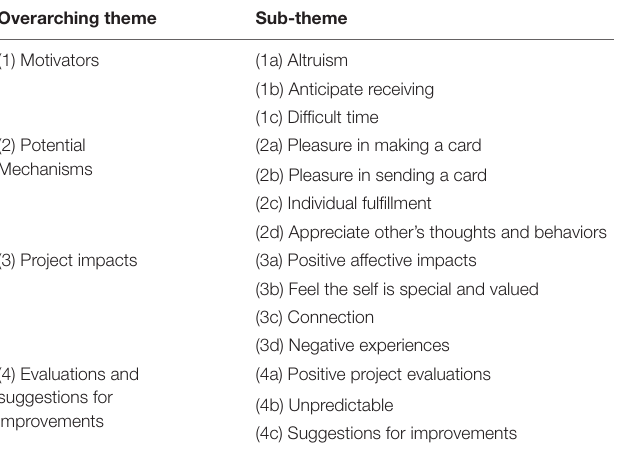
TABLE 4 | Themes generated regarding how KBP was experienced by participants and how KBP achieved the